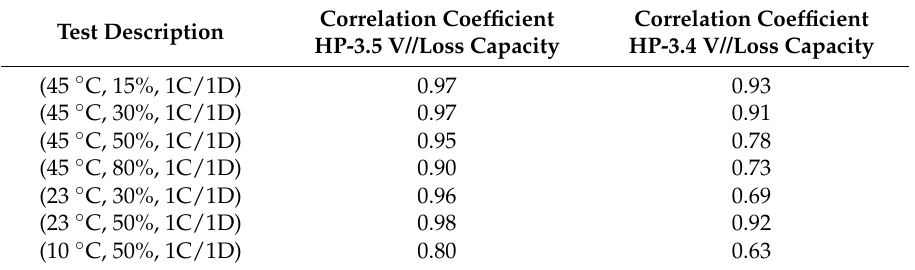
Table 4. Correlation coefficient of highest peak with the total loss of capacity for different tests.